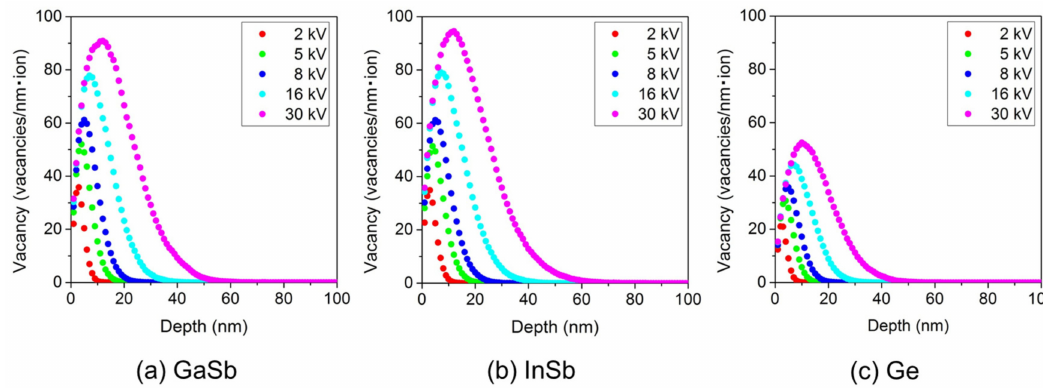
Figure 1. Vacancy distributions of ( a ) GaSb, ( b ) InSb, and ( c ) Ge irradiated with a Ga ion beam as a function of distance from the surface, calculated by SRIM simulations. Accelerating voltages were 2, 5, 8, 16, and 30 kV.